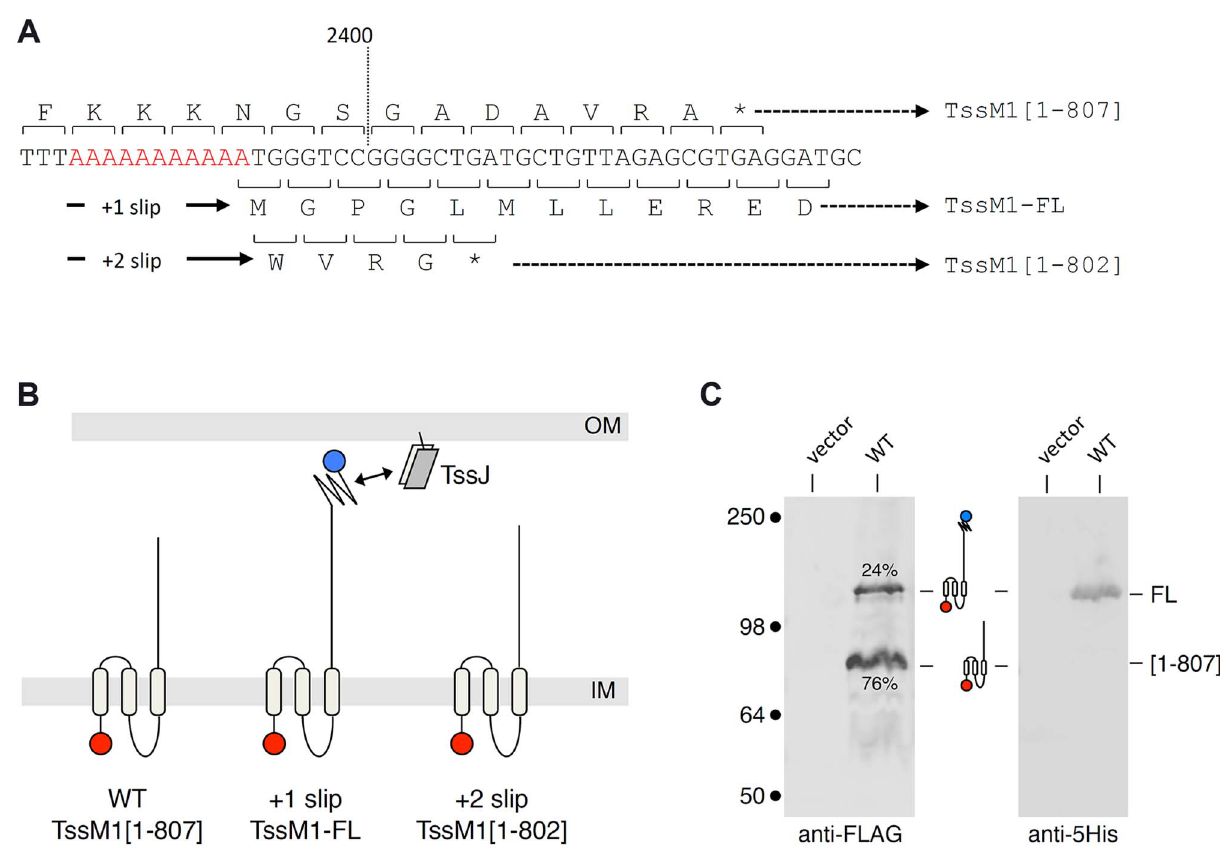
Figure 1. The C.rodentiumtssM1 gene encode two size variants. (A) Representation of the nucleotide sequence of C. rodentium tssM1 . The 11- nt poly-A tract is shown in red. The codons and the amino-acids resulting from translation of the WT sequence, as well as those produced from + 1 or + 2 frameshifting are indicated (stops identified by the asterisks) with the size of the corresponding TssM1 variants. (B) Schematic representation of the putative localizations and topologies of the TssM1[1–807] (produced from the WT sequence), TssM1-FL (produced from + 1 frameshifting) and TssM1[1–802] (produced from + 2 frameshifting) proteins. The locations of the N-terminal FLAG and C-terminal 6 6 His epitope tags are indicated by red and blue balls respectively (IM, inner membrane; OM, outer membrane). (C) Western-blot analyses of C. rodentium cells producing (WT) or not (vector) the TssM1 protein bearing a FLAG-epitope tag at the N-terminus and a 6 6 His tag upstream the stop codon resulting from + 1 frameshifting. Crude extracts from 10 9 cells were subjected to 10%-acrylamide SDS-PAGE and immunodetection using the anti-FLAG and anti-5His monoclonal antibodies. The positions of the TssM1-FL and -[1–807] variants are indicated on the right, with the schematic representation in the middle. The relative intensities of these two TssM1 variants are indicated (as %). Molecular weight markers (in kDa) are indicated on the